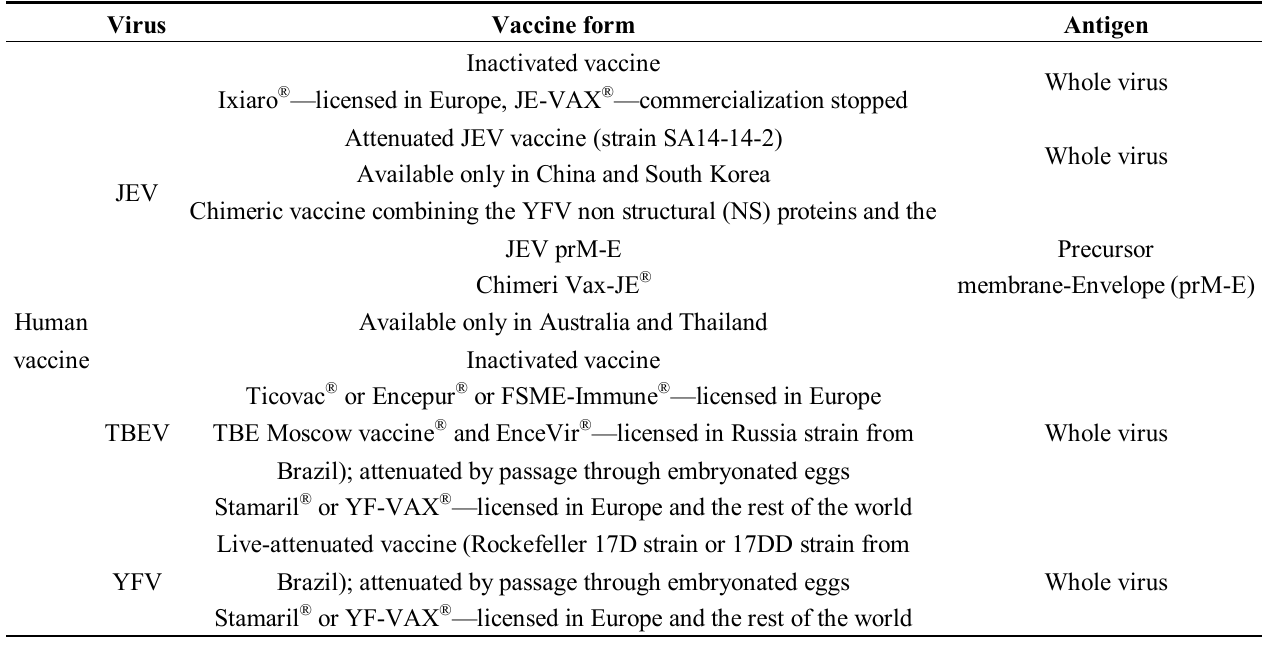
Table 1. Types of flavivirus vaccines approved for use in target species (humans and horses) in Europe or elsewhere in the world if not available in